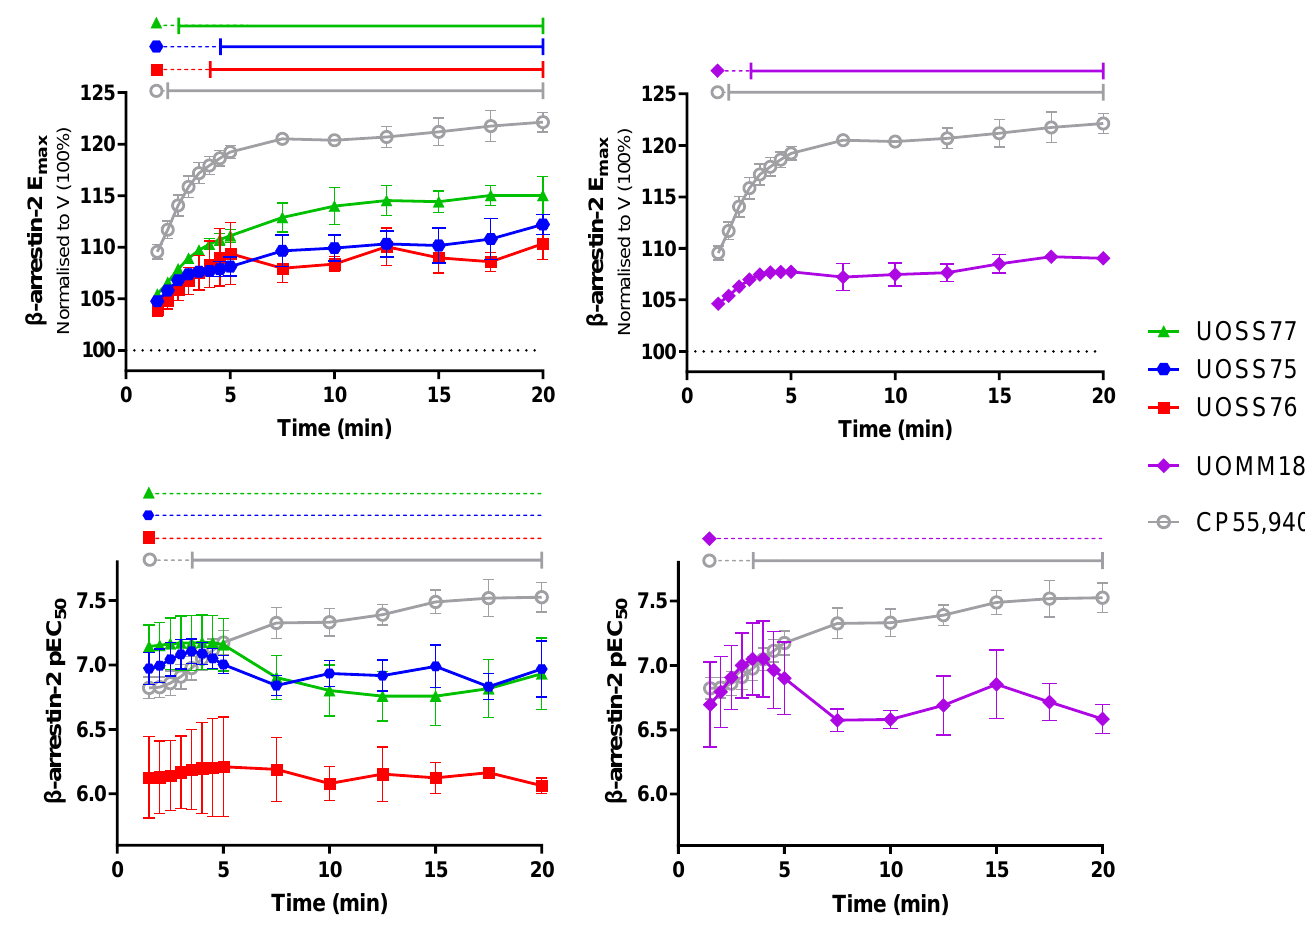
Figure 5. β-arrestin-2 plasma membrane translocation efficacy (E max ; top panels) and potency (pEC 50 ; bottom panels) at different time-points during a 20 min stimulation with compounds of interest. Parameters were derived from concentration response curves generated at corresponding time-points with data normalised to vehicle-treated (as in Figures 4 and S2), then 100% subtracted (V; 100%), implying that larger E max values indicate proportionally greater efficacy than the vehicle measurement. Data are mean ± SEM from three independent experiments. Horizontal lines across the top of plots indicate results of within-drug statistical comparisons to the reference time-point (first robust concentration response curve), which is indicated by the dataset symbol. Solid capped lines indicate significant difference from the reference time-point ( p < 0.05), whereas dotted lines indicate no significant difference from the reference time-point.